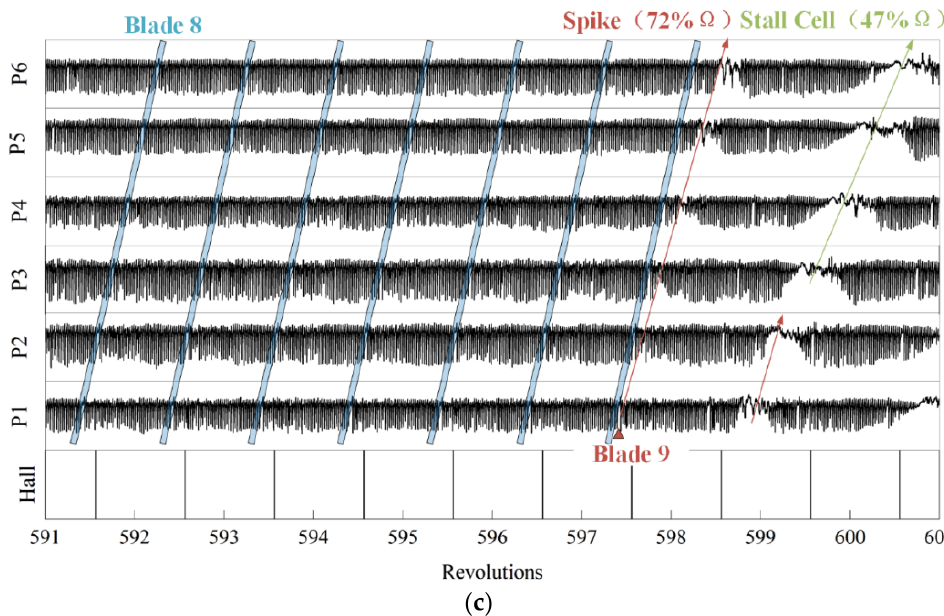
Figure 14. Casing static pressure traces during stall inception ( a ) for Case 0, ( b ) for Case 1, and ( c ) for Case 2.